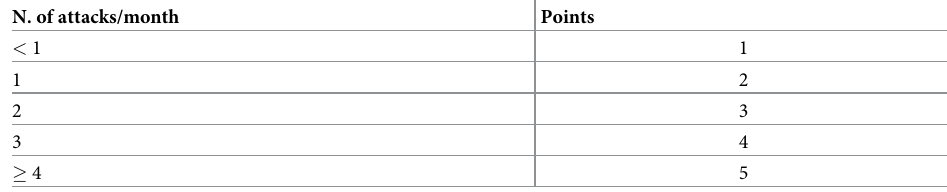
Table 2. Score to categorize the severity of angioedema course based on the number of attacks per month. N. of attacks/month